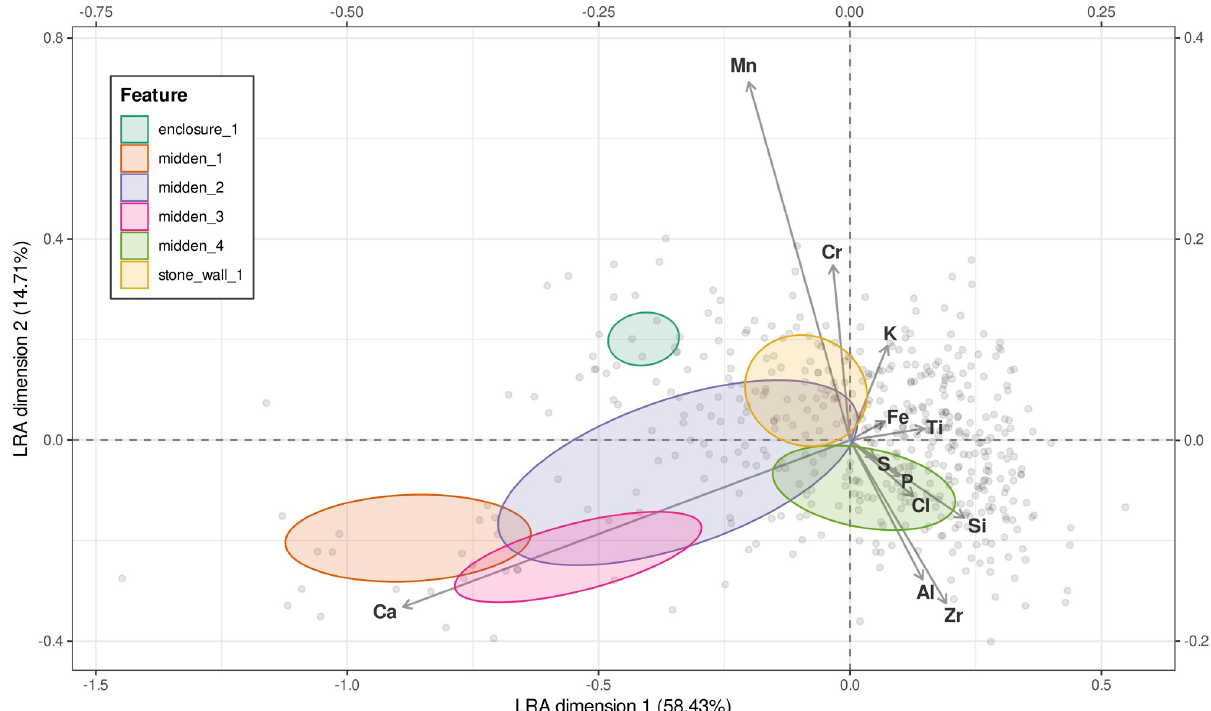
Fig 5. Unweighted Logratio Analysis (LRA) biplot of samples, with 95% confidence ellipses for the feature types (enclosure 2 has been excluded).